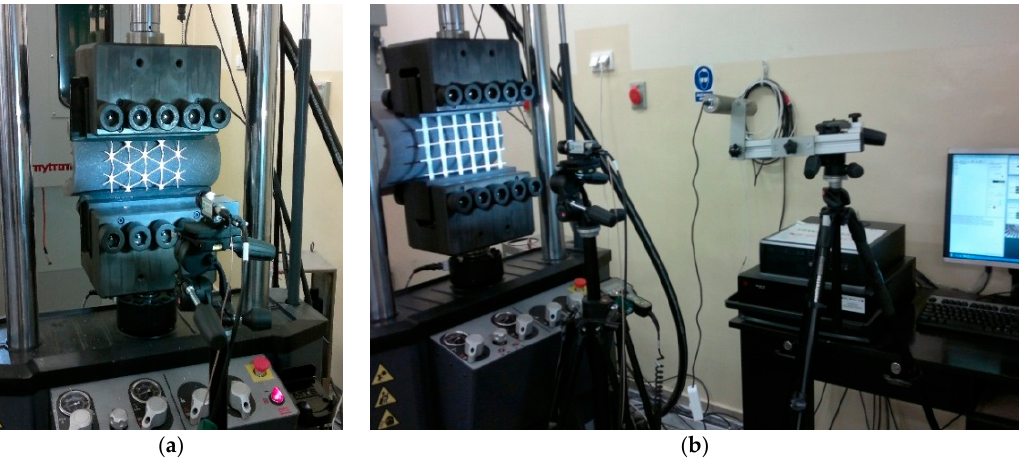
Figure 9. Laboratory stand for geosynthetics testing using the DIC method: ( a ) Sample of hexagonal geogrid; ( b ) sample of orthogonal geogrid [24,38].